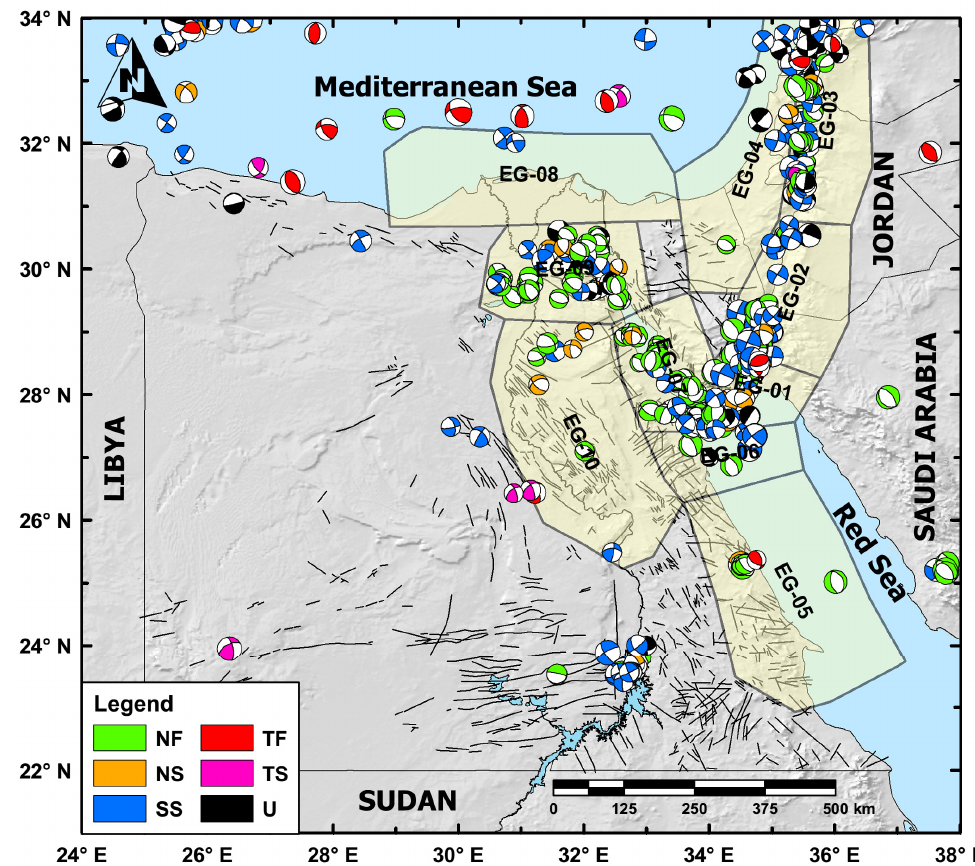
Figure 5. Spatial distribution of lower hemisphere equal-area projection for the focal-mechanism solutions dataset (after [61]). Black lines refer to the faults defined by the EGSA [62]. Sizes and colors of the plotted focal mechanism are relative to their moment magnitudes and faulting types, respectively. NF: normal-faulting, NS: normal with a strike-slip component, SS: strike-slip faulting, TF: thrust faulting, TS: thrust with a strike-slip component, U: undefined.